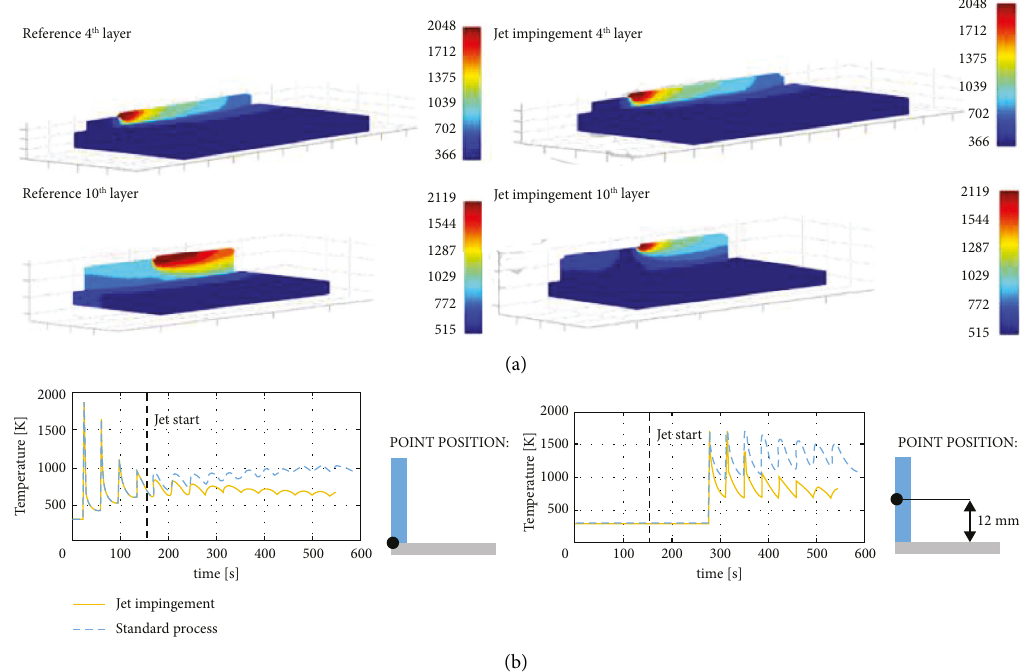
Figure 19: Comparison of temperature field (K) of reference and jet impingement simulations: contour plot during the deposition of 4th and 10th layers (a); temperature-time histories of two nodes at different distances from the base plate